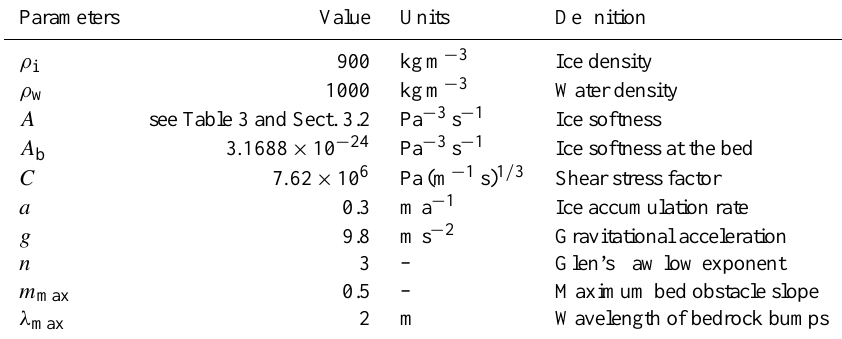
Table 2. Parameter values used for all